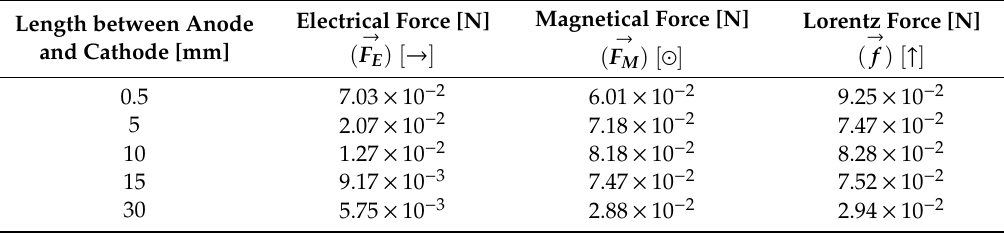
Figure 7. Comparison graphs of electric force, Magnetic force and Lorentz force. Table 2. Electrical force, Magnetic force, and Lorentz force according to the length between anode and